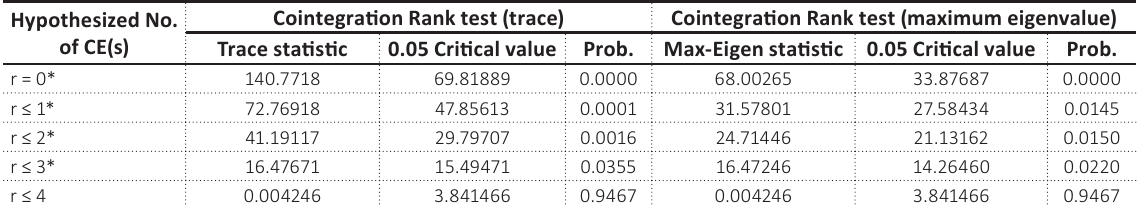
Table 3. Cointegration rank